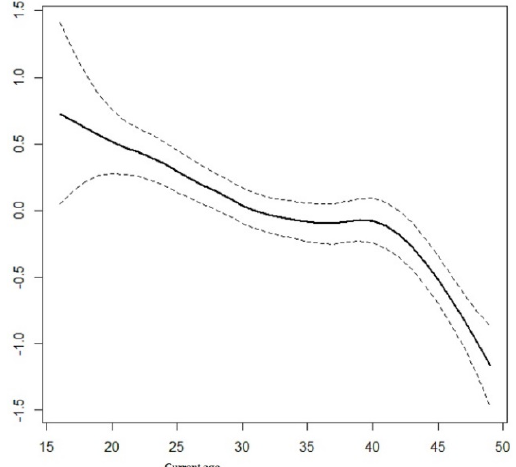
Figure 1. Effects of woman’s current age on the use of contraceptive methods.